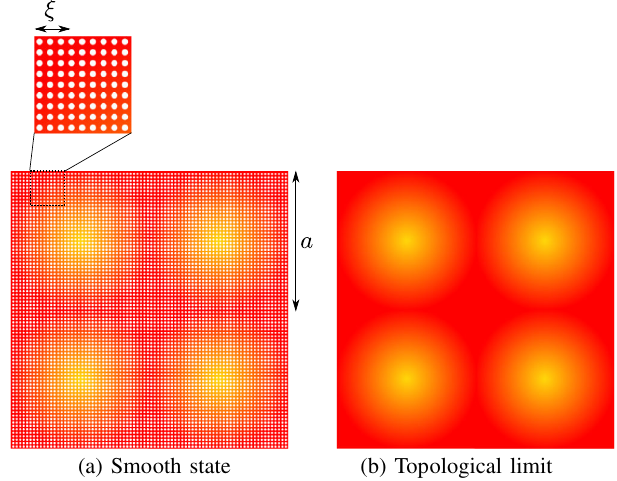
FIG. 1. (a) In a smooth state, the lattice spacing and the correlation length ξ are much less than the unit cell size a and the radius of spatial variation. (b) The topological response of a crystalline topological liquid is captured by a spatially dependent TQFT that captures the spatial dependence within each unit cell but “ forgets ” about the lattice.